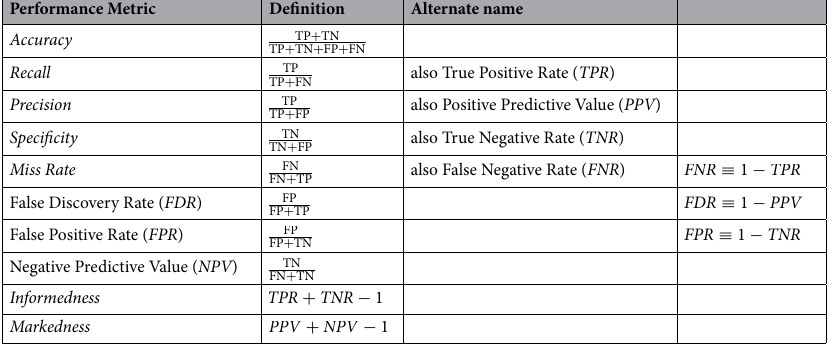
Table 2. Common measures used in this paper to gauge the performance of classification tasks. In the formulae above, TP (True Positives) is the number of correctly classified concussed individuals; TN (True Negatives) is the number of correctly classified control participants; while FP and FN are the numbers of falsely classified control (i.e. False Positives) and concussed (i.e. False Negatives) participants, respectively.